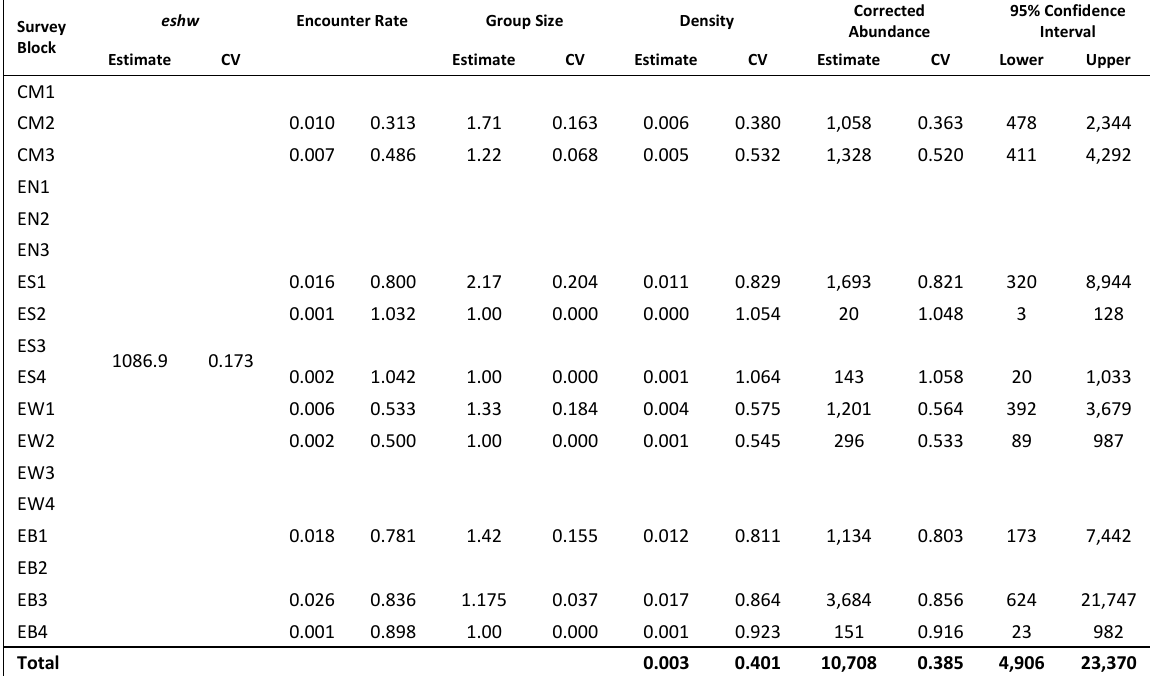
Table 7. Estimated density and abundance of humpback whales. The eshw (effective search half width (m)) was estimated for the entire study area. Encounter rate, group size, density, abundance, and upper and lower confidence limits were estimated by block and corrected for perception bias, with the estimated p (0).